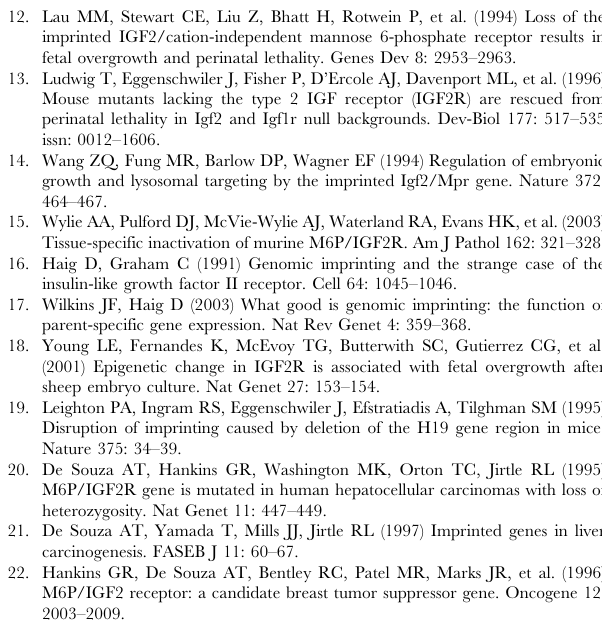
Table S1 Mass spectrometry identification of the